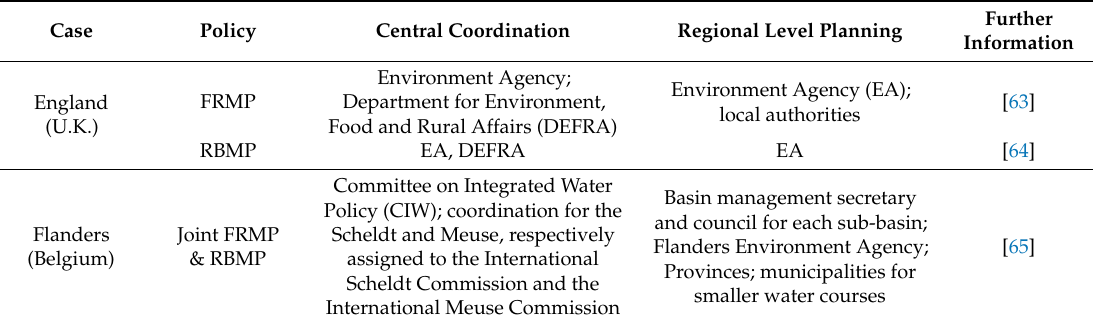
Table A4. The main organizations leading WFD and FD implementation in our nine interview cases, as derived from WFD implementation reports and our interviews. Where more than one organisation is listed as providing central coordination, the first is the “competent authority”. Published sources provide further reading on the formal governance structures in each